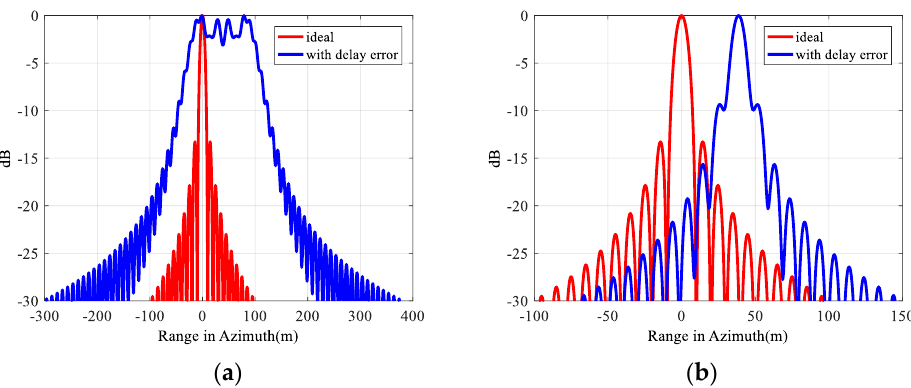
Figure 4. The azimuthal profiles of point target imaging of low-inclination GEO SAR at perigee. ( a ) L-band. ( b ) X-band.